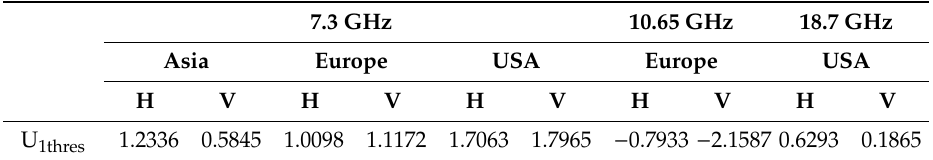
Figure 9. Scatterplots of DPCA u 1 and RFI index for H-pol (left panels) and V-pol (right panels) polarization using GRDM. ( a , b ) 7.3 GHz, Asia; ( c , d ) 7.3 GHz, Europe; ( e , f ) 7.3 GHz, USA; ( g , h ) 10.65 GHz, Europe; ( i , j ) 18.7 GHz, USA. Table 3. Values of u 1threshold for different channels.